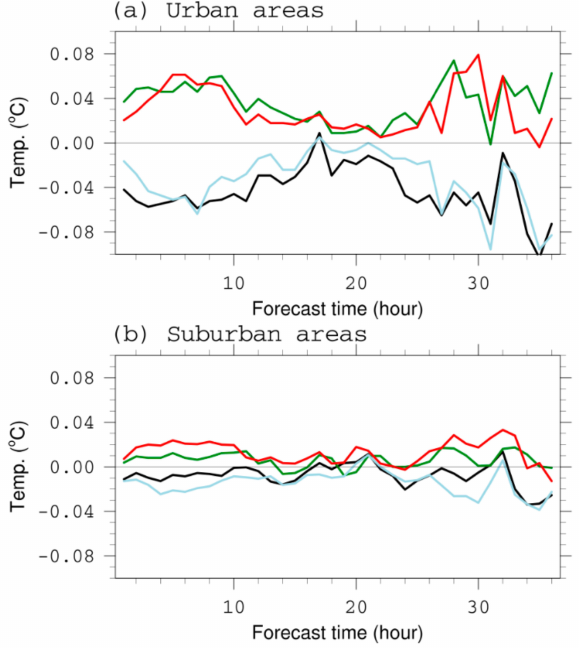
Figure 7. Time series of 1.5-m temperature averaged in ( a ) urban areas (urban fraction ≥ 0.3) and ( b ) suburban areas (urban fraction < 0.3) in AWP (black), AWN (red), ARP (blue), and ARN (green).